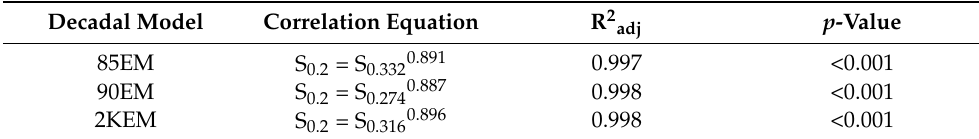
Table 4. The S correlation equation for each decadal group in East